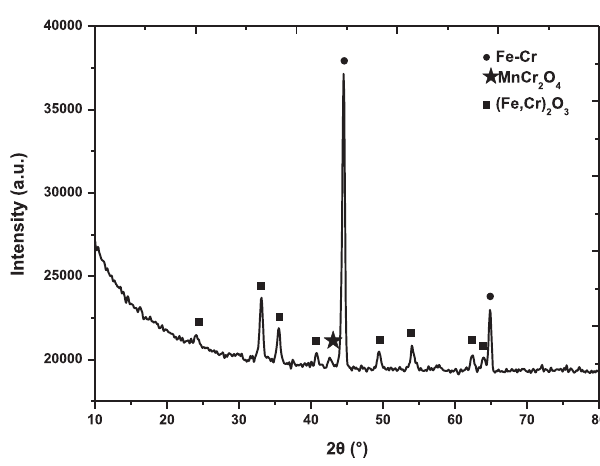
Figure 8: XRD of the pre-oxidized